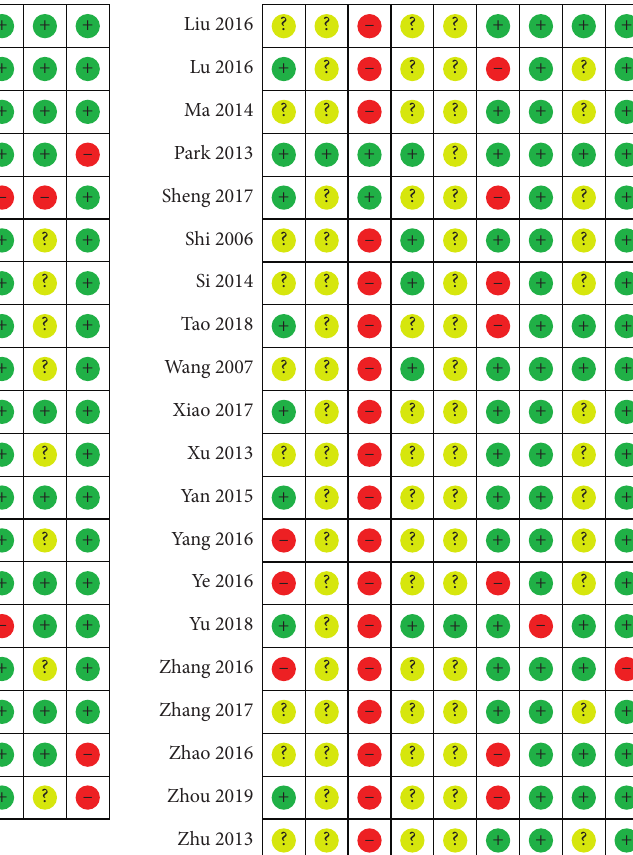
Figure 3: Risk of bias graph: review authors’ judgements about each risk of bias item presented as percentages across all included studies. (a) Random sequence generation (selection bias). (b) Allocation concealment (selection bias). (c) Blinding of participants and personnel (performance bias). (d) Blinding of outcome assessment (detection bias) (patient-reported outcomes). (e) Blinding of outcome assessment (detection bias) (investigators-reported outcomes). (f) Incomplete outcome data (attrition bias). (g) Selective reporting (reporting bias). (h) Funding source (other bias). (i) Baseline data compatibility (other